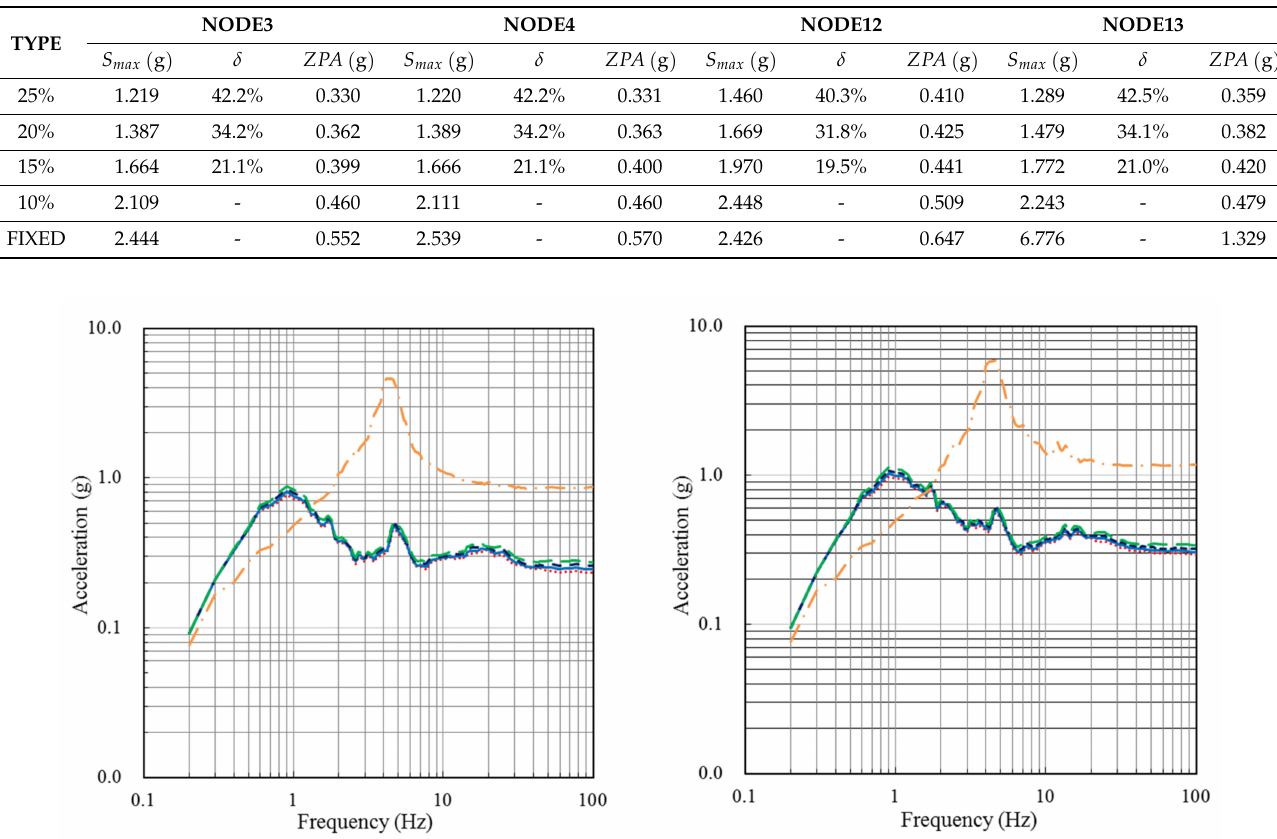
Table 4. Comparison of peak values and ZPA of the FRS in the vertical direction.